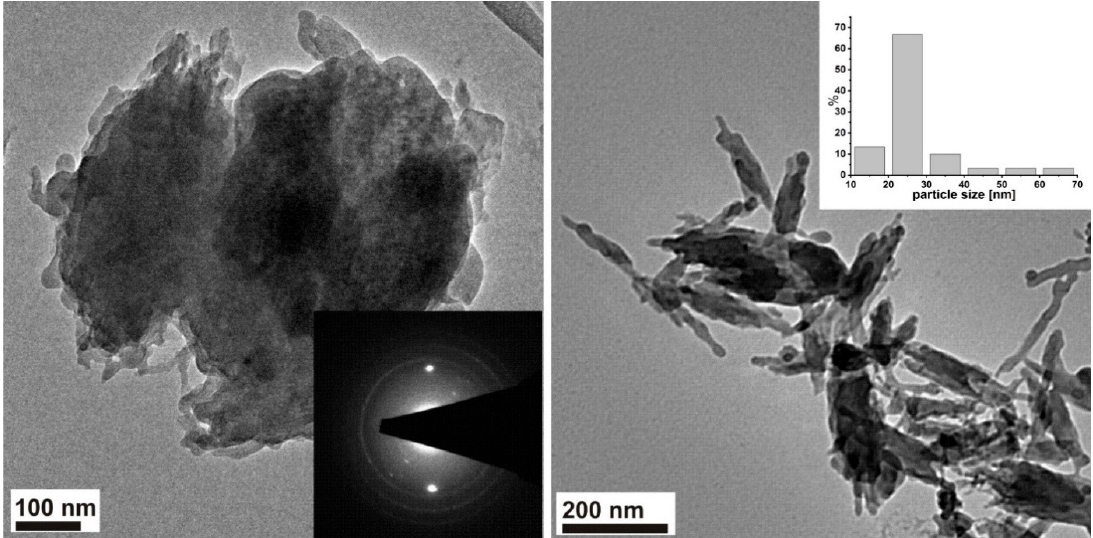
Figure 2. TEM images with a SAED pattern (insert in left image) as well as with particle size distribution (insert in right image) for the investigated graphene oxide material.